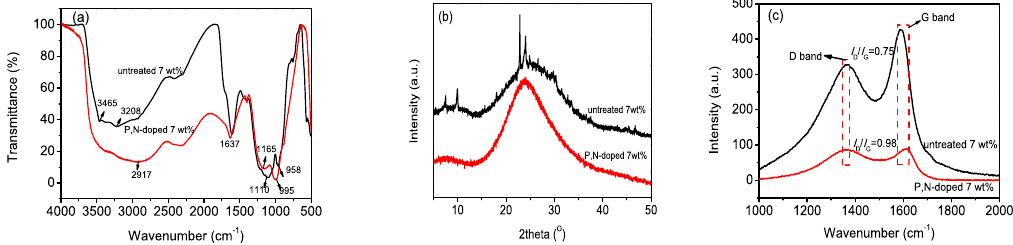
Figure 9. Characteristics of char residues of HDPE with 7 wt % untreated and P,N-doped cellulose after combustion: ( a ) FTIR spectra, ( b ) XRD spectra, and ( c ) Raman spectra. after combustion: ( a ) FTIR spectra, ( b ) XRD spectra, and ( c ) Raman